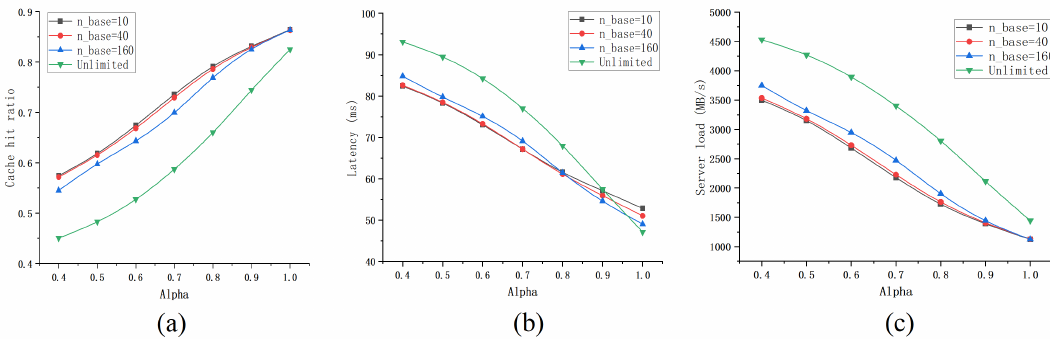
Figure 3. Performance of PB-NCC with different n base when the Zipf parameter α changes. ( a ) the cache hit ratio under different Zipf parameter α ; ( b ) the average latency under different Zipf parameter α ; ( c ) the server load under different Zipf parameter α .